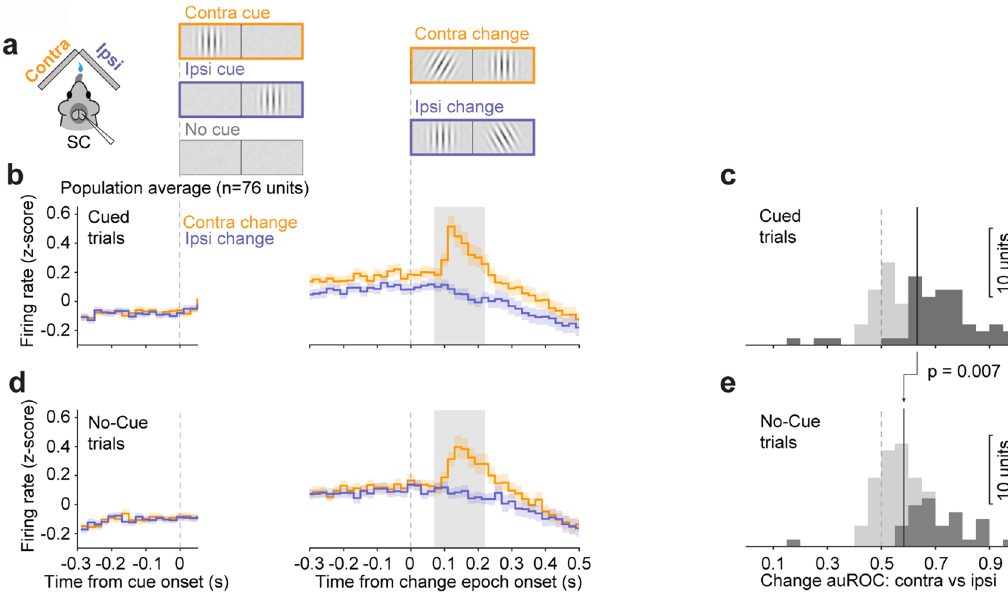
Figure 5. Spatial cueing can improve the detection of orientation changes if neuronal activity is compared across the contralateral and ipsilateral SC. ( a ) Schematic of apparatus and events in “cue/no-cue” task. ( b ) Average normalized population PSTHs of SC neurons during “cue-contra” change trials (orange) and “cue-ipsi” change trials (blue). Traces are aligned on the onset of the cue epoch (left panel, highlighting pre-cue baseline activity) and onset of the orientation change (right panel). Gray area: 150 ms change interval (60–210 ms after change onset) used to compute auROC comparing contralateral and ipsilateral change trials. ( c ) Distribution of change auROCs in cued trials. Dark bars are units with auROCs significantly different from chance level. Dashed line indicates chance value of 0.5, solid line indicates population median (0.63). ( d ) Presentation as in ( b ) but comparing “no-cue contra” (orange) to “no-cue ipsi” (blue) change trials. ( e ) Presentation as in ( c ), but in no-cue trials; (median = 0.58). The p value indicates comparison of population median between ( c ) and ( e ), paired-sample Wilcoxon signed-rank